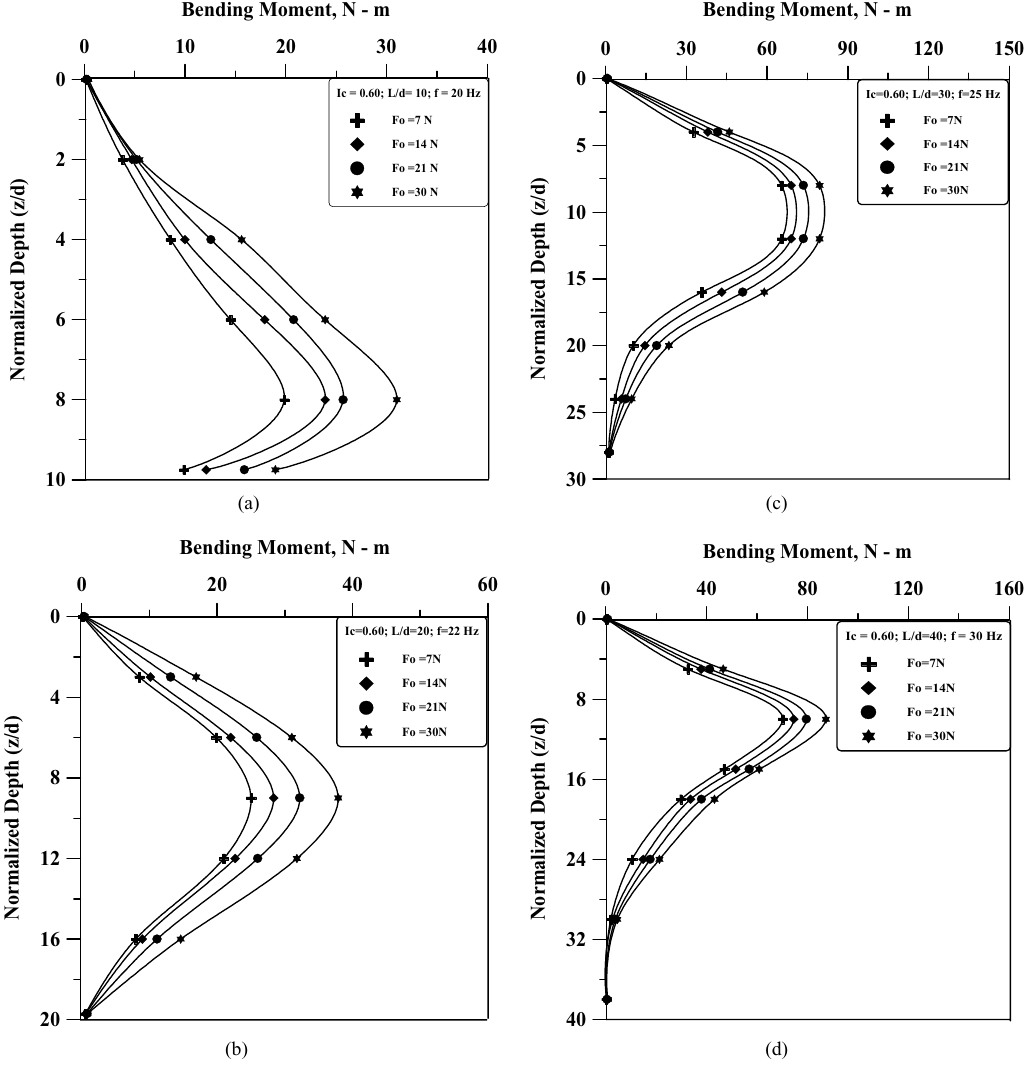
Fig. 15. Variation of dynamic bending moment of piles with normalized depth for I c = 0.60 (a) L/d = 10; (b) L/d = 20; (c) L/d = 30 (d) L/d = 40. obtained from the measured peak strain at the natural frequency of the soil-pile system by multiplying the calibration factor obtained from the calibration test conducted on the instrumented model